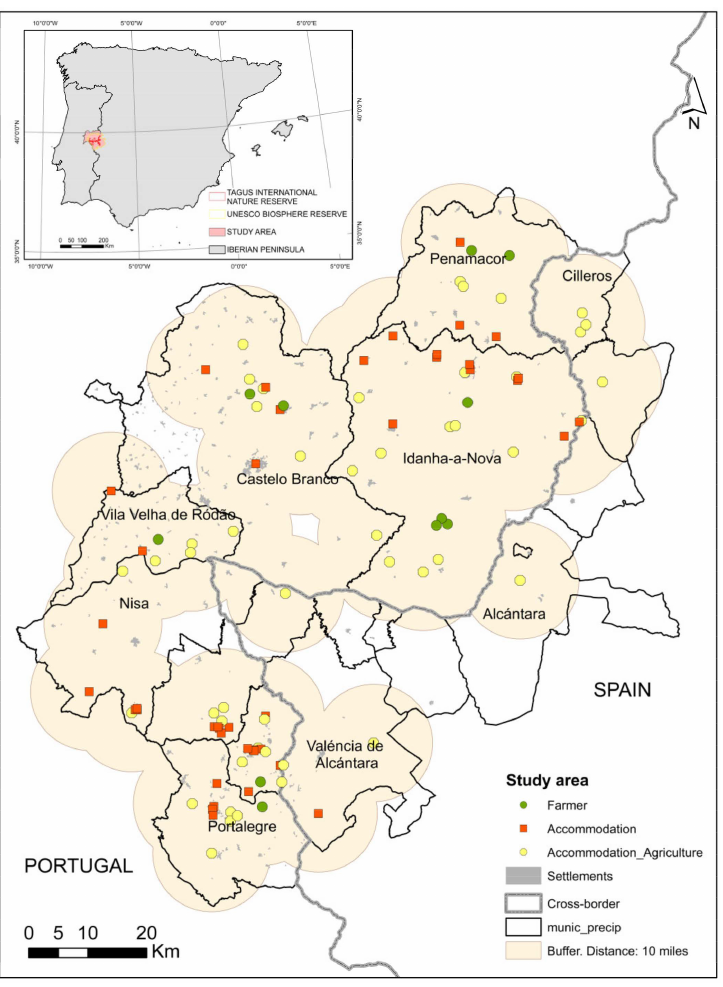
Figure 2. Study area and cases study